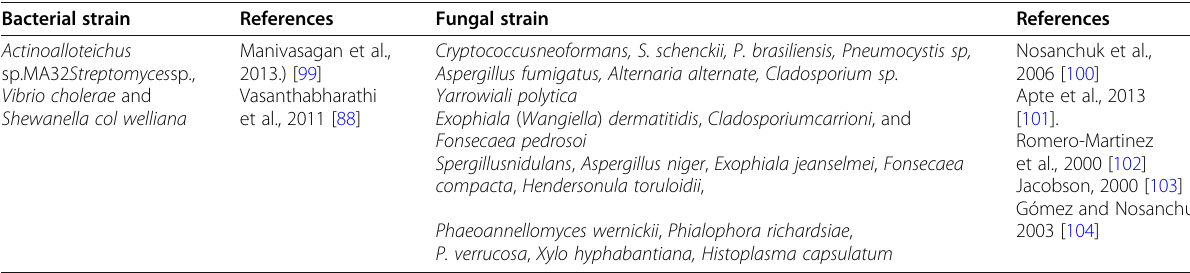
Table 4 Enhanced melanin production from microbial in origin at a glance Bacterial